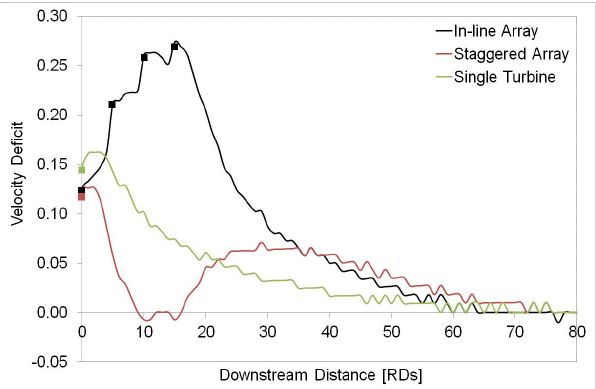
Figure 15. Longitudinal velocity deficits for the in ‐ line and staggered arrays plotted along the transects in Figure 11a,b and along the centreline through a single isolated turbine (the squares indicate turbine locations).